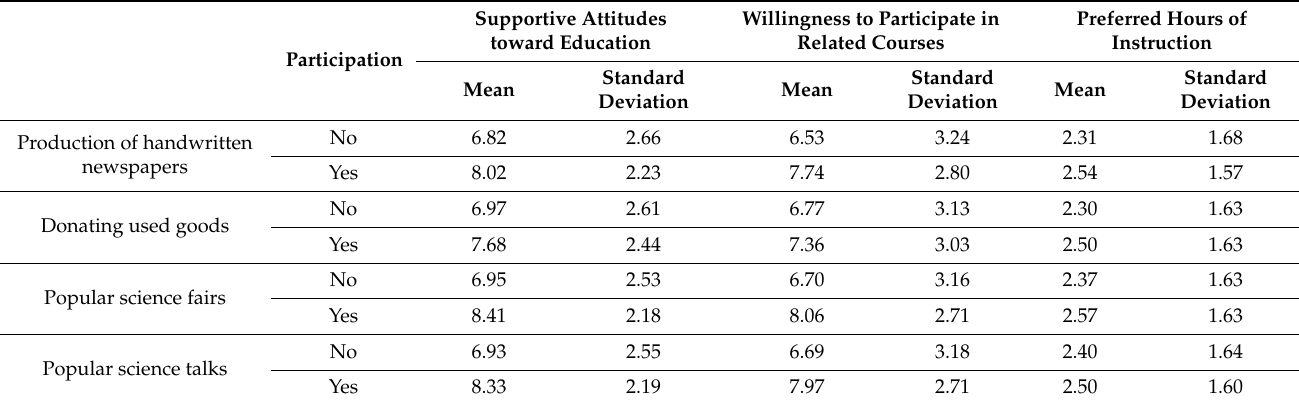
Table A2. Descriptive statistics results.